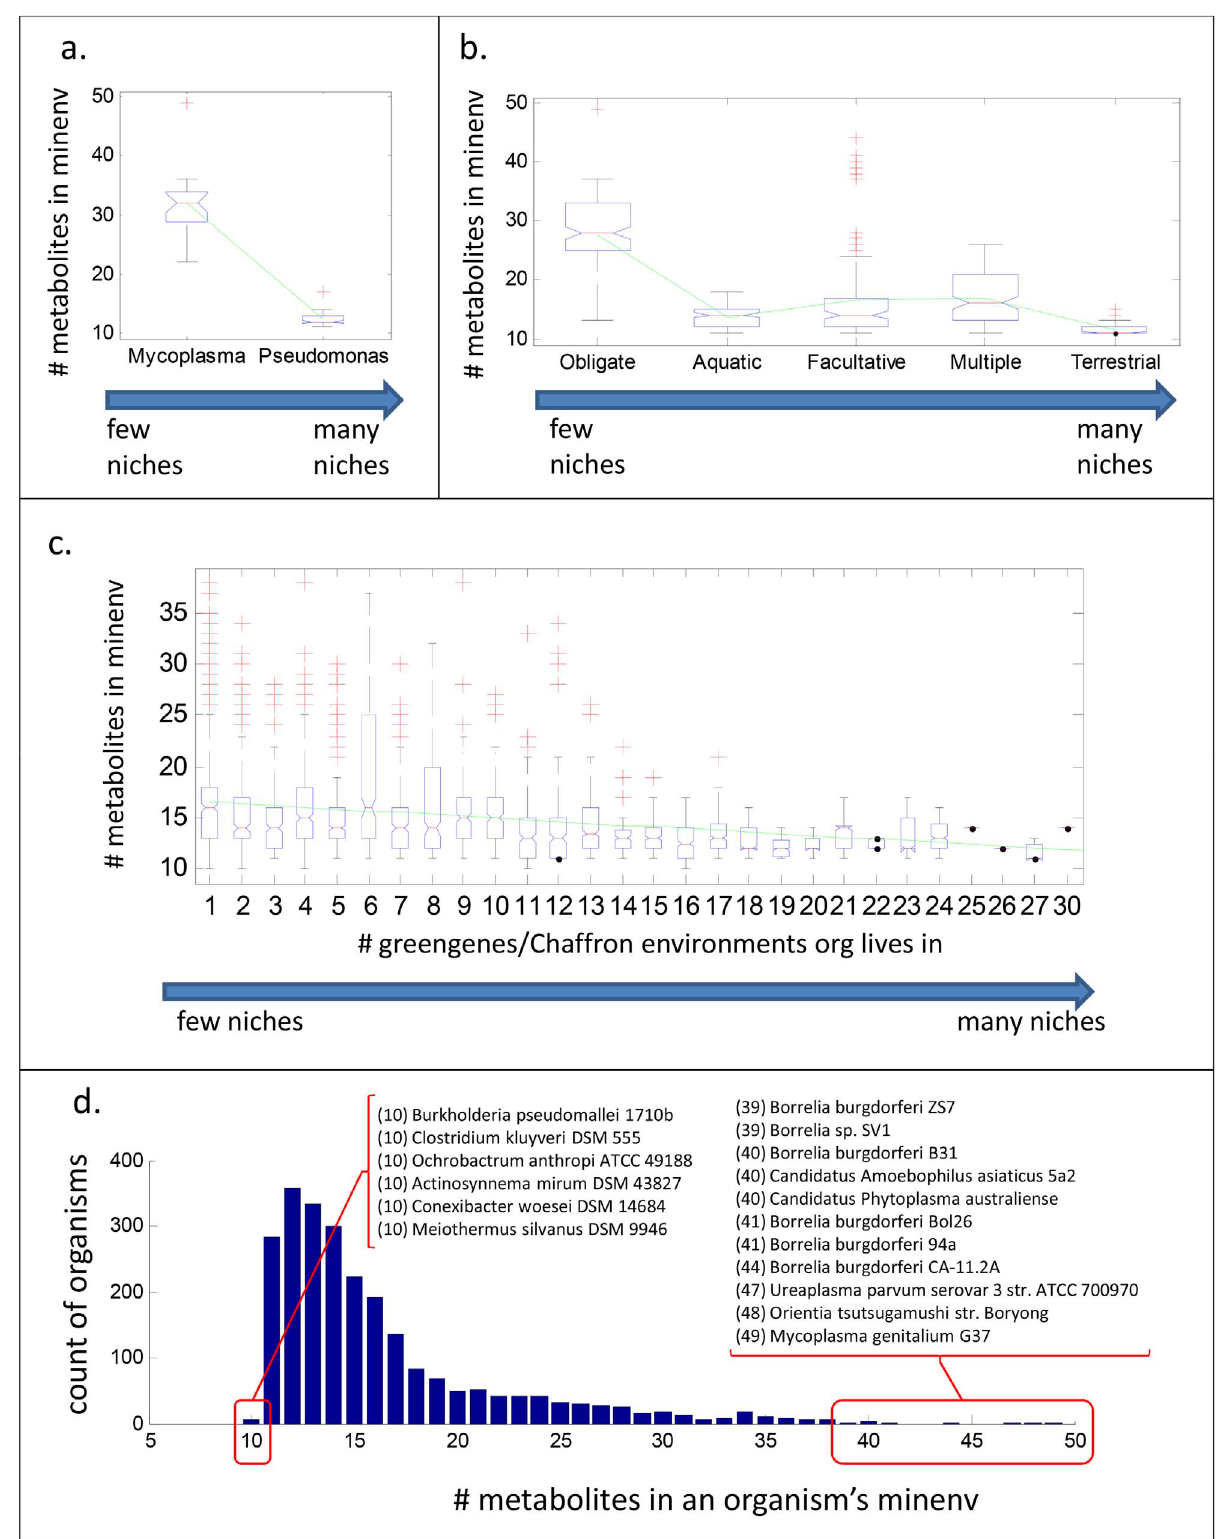
Figure 3. Nutritional fastidiousness scales negatively with breadth of ecological environments. This trend is shown (A) between species of Mycoplasma and Pseudomonas , (B) between five lifestyle categorizations with ascending environmental breadth, and (C) in environmental distributions in Greengenes. (D) shows a histogram of the number of organisms with different sized minenvs. Species on the extreme ends are listed.